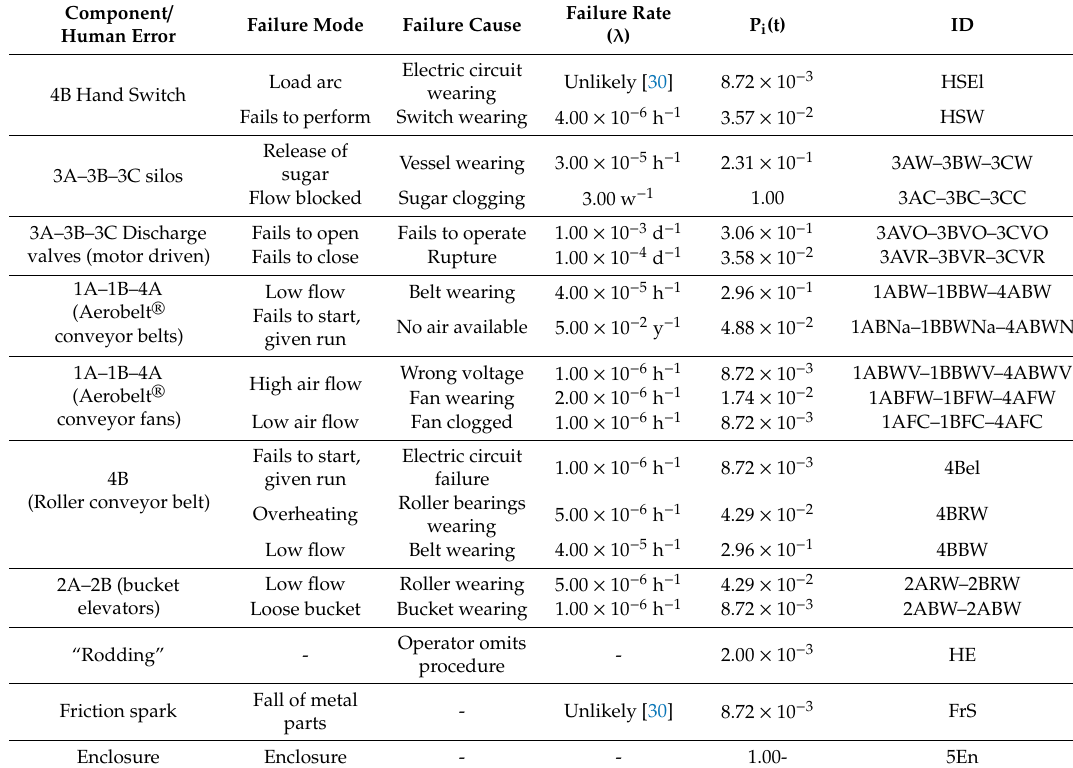
Table 8. Unavailability of components and human